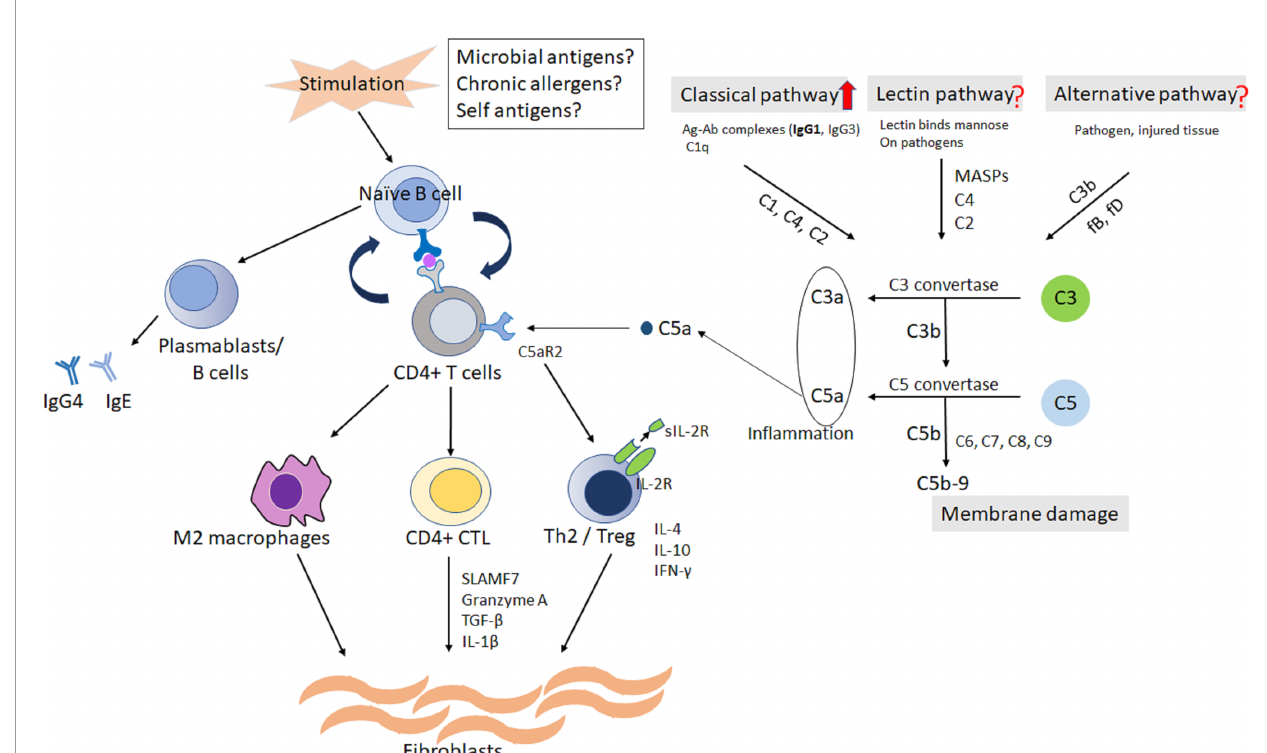
FIGURE 4 | The hypothesis of pathophysiology in IgG4-RD. Naïve/memory B cells and/or dendritic cells would present antigen from possible triggers to CD4 positive T cells. The cycle of collaboration would be established between autoreactive T cells and B cells. The activated CD4 positive Th2 and regulatory T cells would produce in fl ammatory cytokines, resulting in activation of fi broblasts and in fl ammatory macrophages. Complement system, at least classical pathway, is possibly related to the differentiation to Treg from CD4 positive T cells through C5aR2. Treg may be associated with the production of sIL-2R. C, complement; CD4, cluster of differentiation 4; C5aR2; C5a receptor 2; CTL, cytotoxic T lymphocyte; Ig, immunoglobulin; IL, interleukin; IFN- g , interferon- g ; Th2, T-helper 2; TGF-b, transforming growth factor-b; Treg, regulatory T cell; SLAMF7, signaling lymphocytic activation molecule F7; sIL-2R, soluble interleukin-2